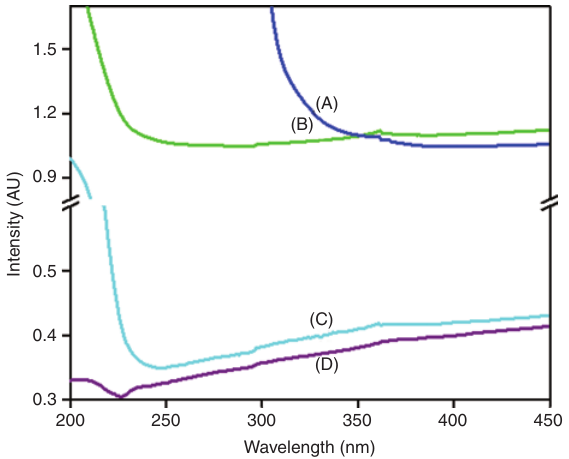
Se nanoparticles capped with (A) 2